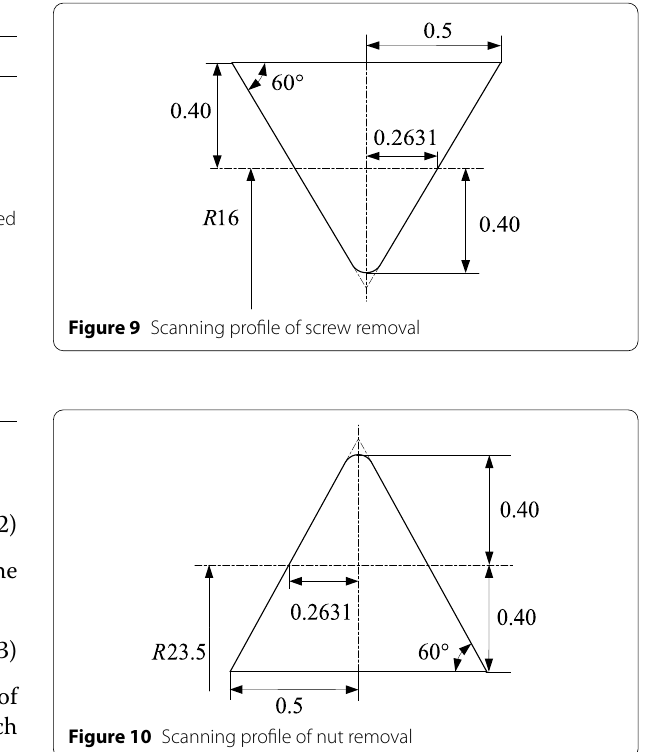
Figure 10 Scanning profile of nut removal